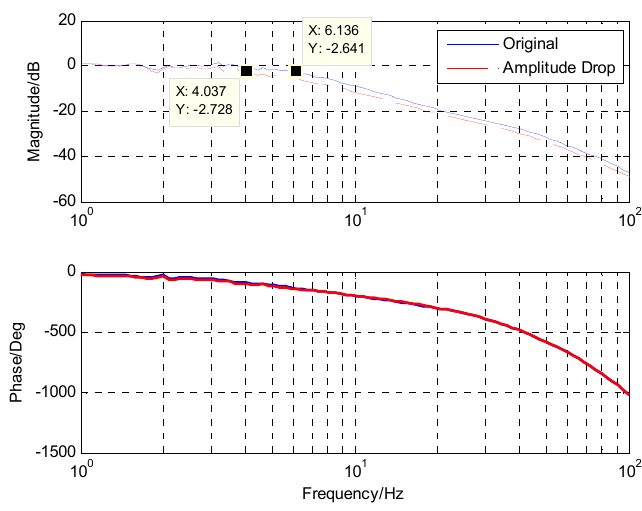
Figure 12. The closed-loop bode responses of the position.